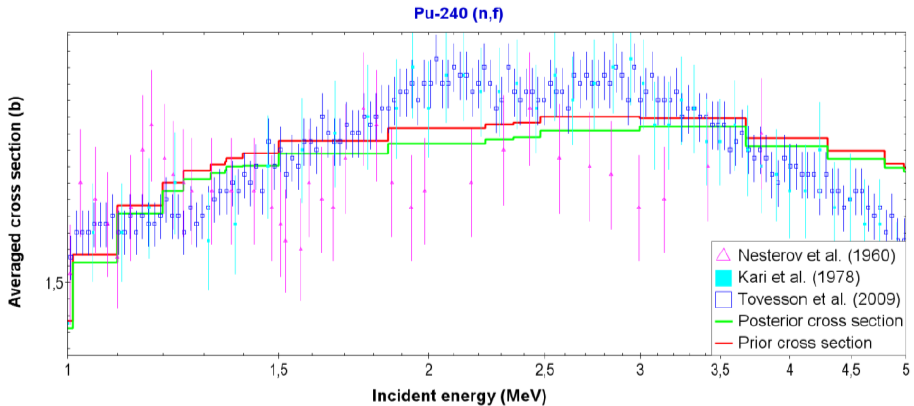
Fig. 2. 240 Pu(n,f) prior and posterior cross sections compared with experimental